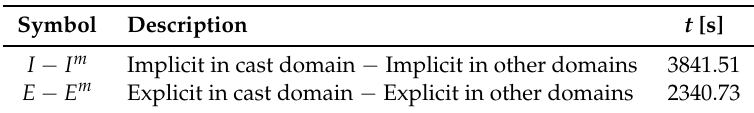
Table 3. A total time t of computations obtained for the traditional methods ( m = 1). The same integration methods and the same time